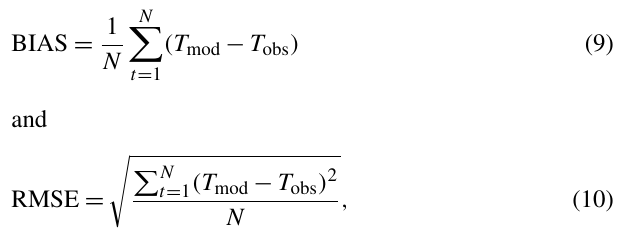
Table 3. GEOtop parameters for different terrain types. Terrain Esker Stratigraphy